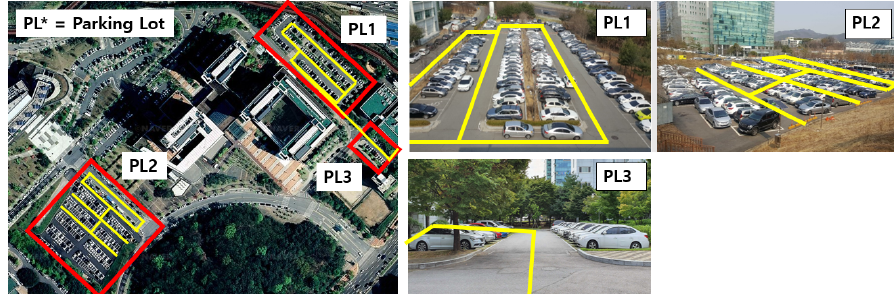
Figure 11. Three outdoor parking lots at the Advanced Institute of Convergence Technology. The yellow lines indicate the path that the autonomous vehicle passed for evaluating the simultaneous localization and mapping (SLAM) performance.